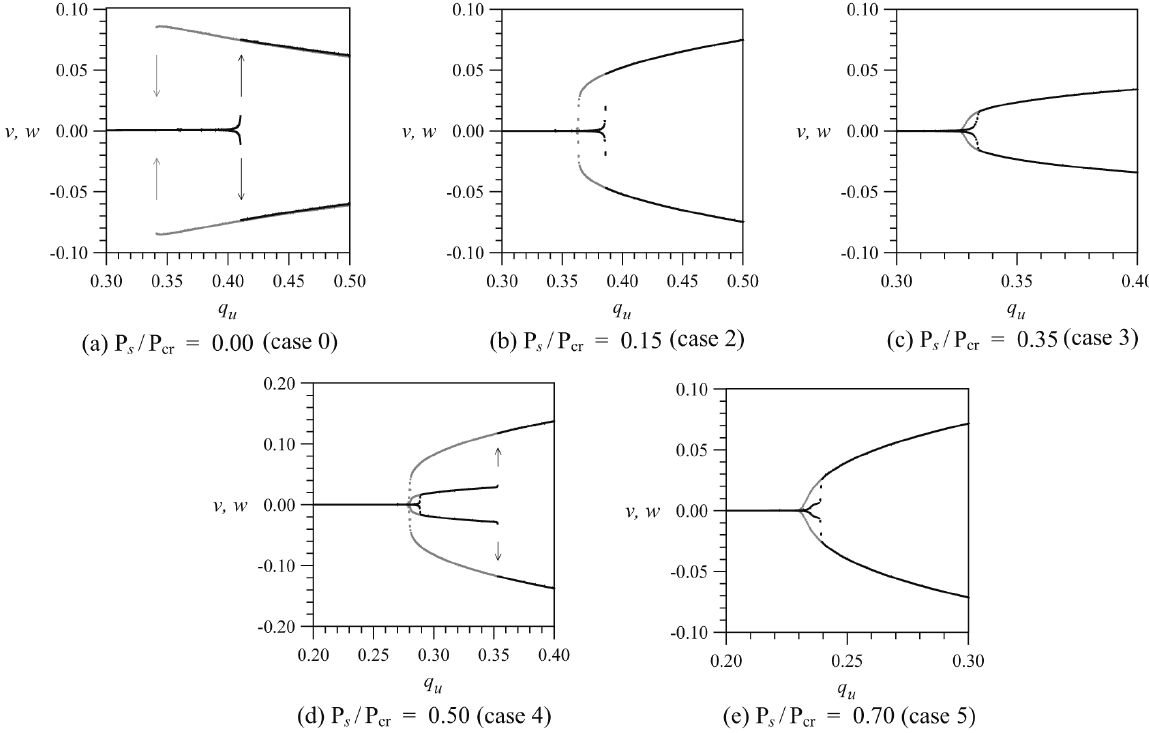
Fig. 12. Bifurcation diagrams of the Poincaré map for the beam subject to increasing static axial load at Ω u = 2 ω 0 .